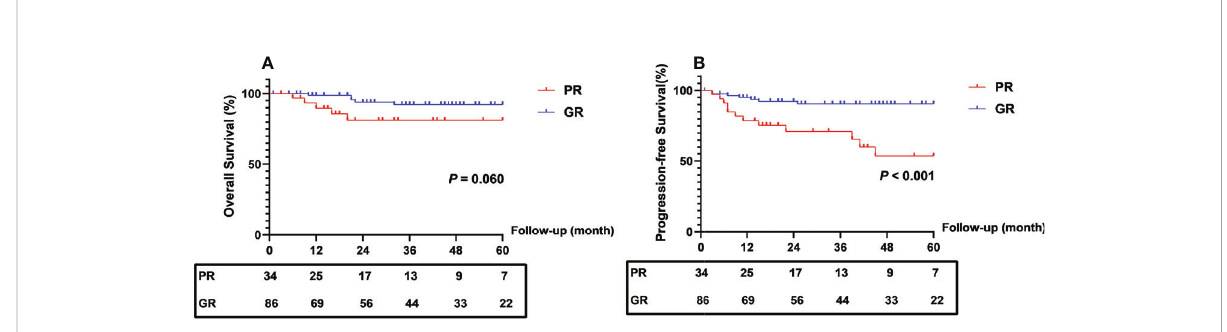
FIGURE 2 Comparison of survival outcomes between patients with different regression response. PR, poor response; GR, good